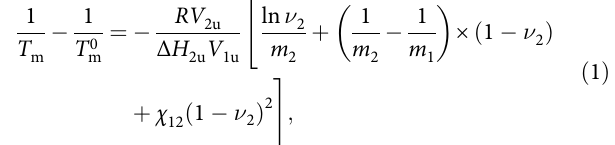
temperature region, it is much smaller than correlation length and the length scale of phase separation. Such difference indicates that crystallization is the major driving force in morphology change in early stage; and in later stage, global phase separation occurs and surpass the crystal-induced phase separation. The latter process yields a quite sharp Porod exponent of ~3.8, and thus such phase separation induces a sharp interface. Therefore, DPPEZnP-TEH:PC 61 BM/Py blend fi lm undergoes coupling and competing phase separation mechanism of crystallization and demixing.